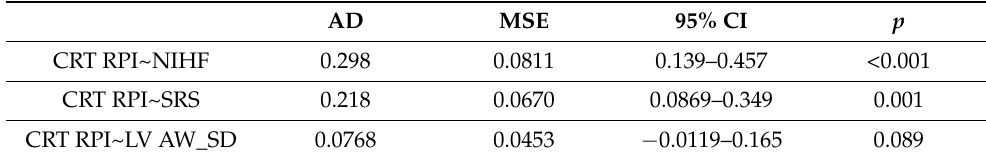
Table 4. The ROC curves’ pairwise